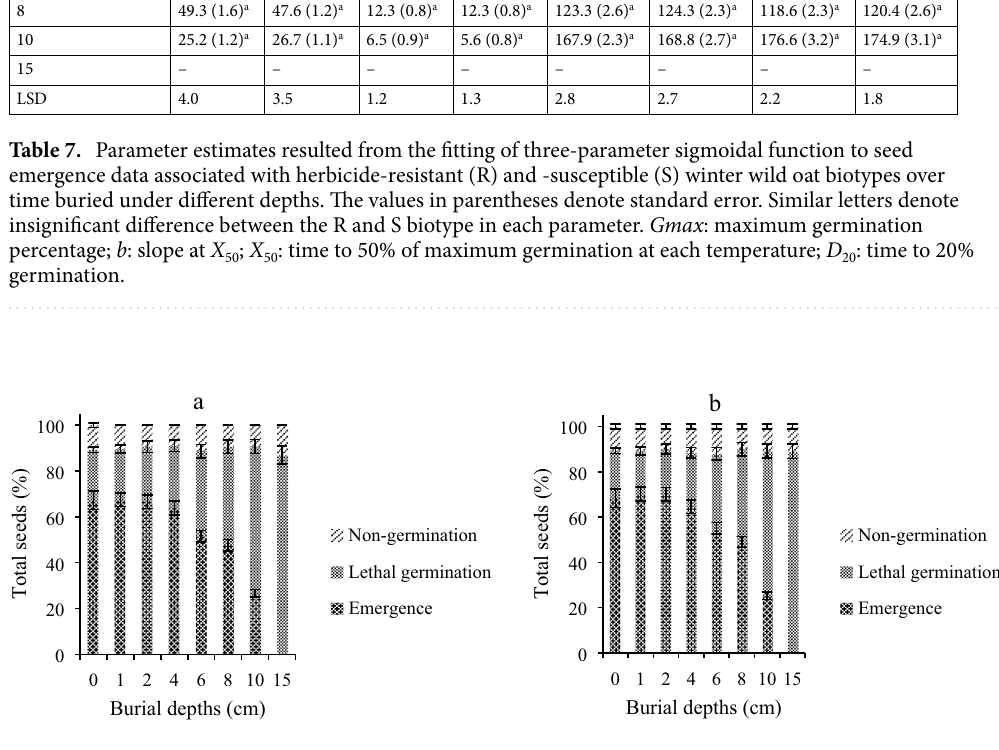
Figure 6. Percentage of the emerged and non-germinated seeds as well as the germinated seeds which failed to reach the soil surface in herbicide-resistant ( A ) and –susceptible ( B ) winter wild oat biotype as affected by different burial depths. The figures were drawn using Microsoft Excel Version 2013 software. The statistical analysis was performed using SAS Version 9 software (SAS Institute Inc., Cary, NC,